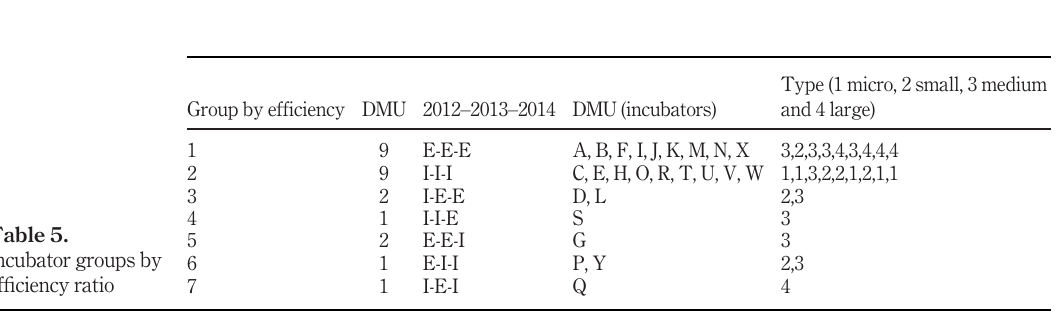
Table 4. Summary of DEA model results